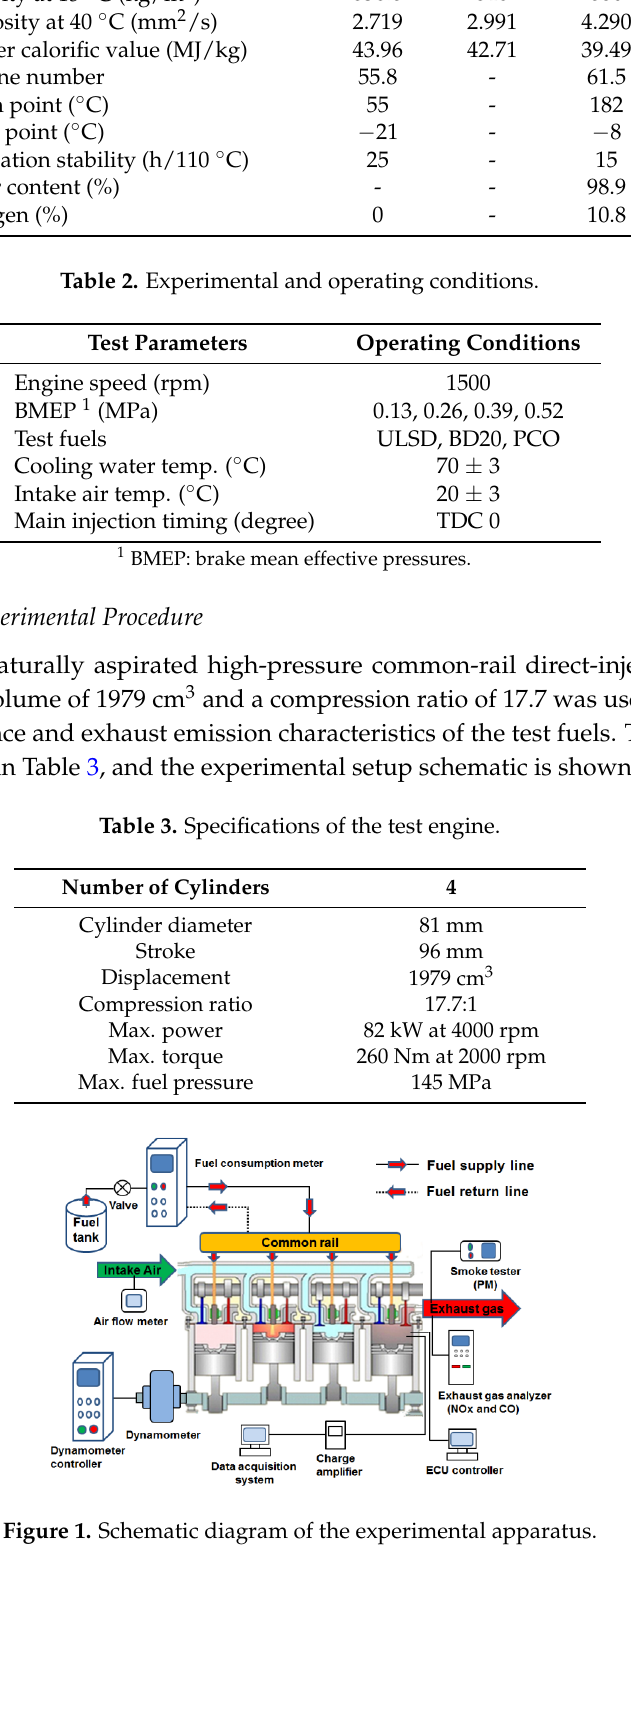
Table 1. Properties of ULSD (ultra low sulfur diesel), BD20 (20% canola oil blended with 80% ULSD by volume), and PCO (pure canola oil) fuels.